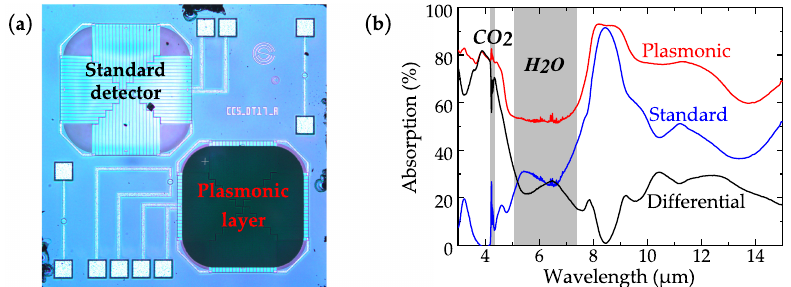
Figure 5. ( a ) Differential filter-free detection, and ( b ) spectral response. Adapted from ref.